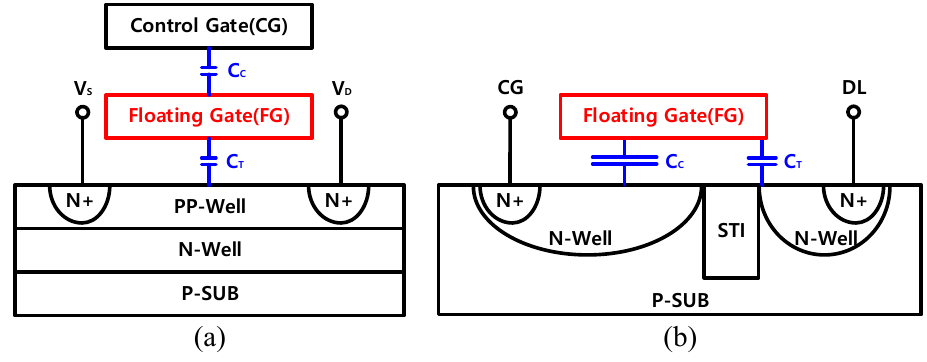
Figure 3. Cross-section view of EEPROM cells with a ( a ) stacked gate and ( b ) planar gate.